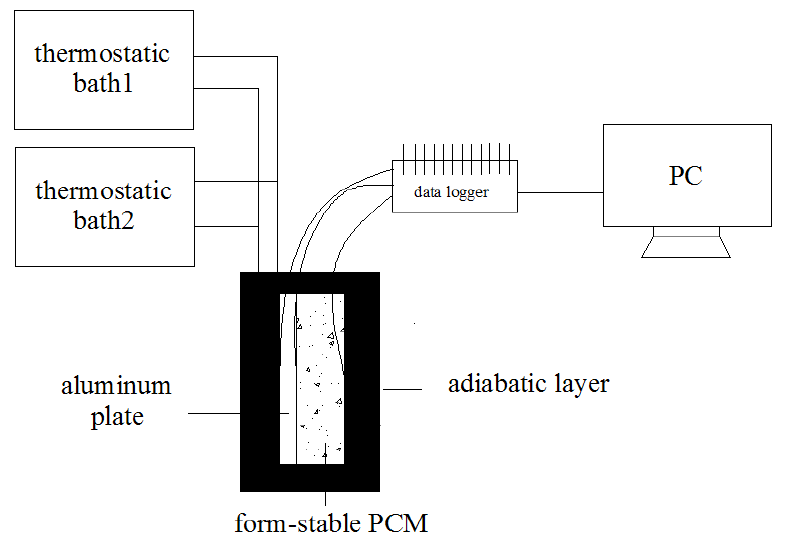
Figure 3. Thermal storage and release process experimental